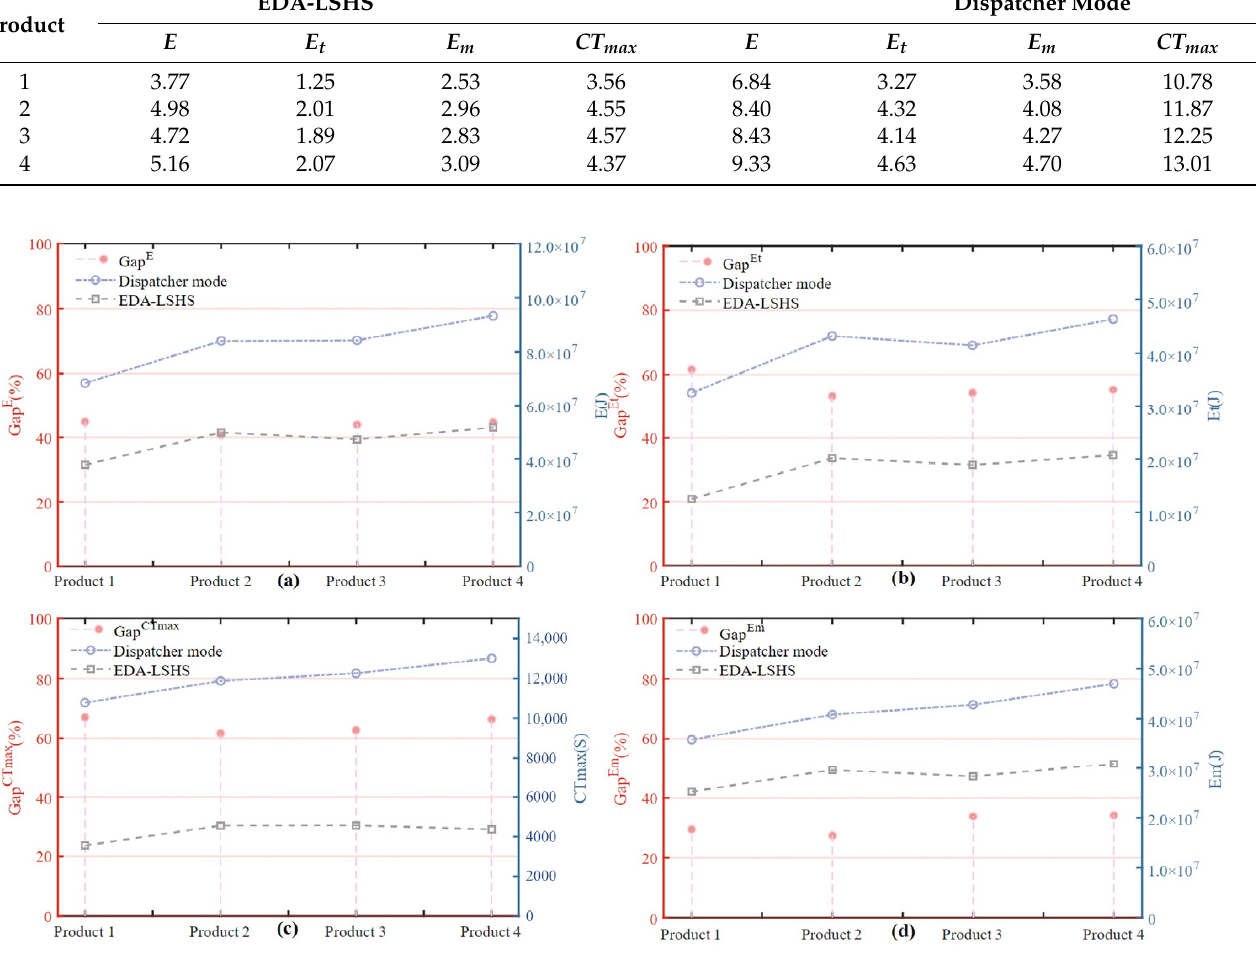
Figure 12. The four gaps in the four product instances: ( a ) Gap E ; ( b ) Gap Et ; ( c ) Gap CT max ; ( d ) Gap Em . Table 4. The max gap, average gap, and min gap of four Table 3. Results for the EDA-LSHS algorithm and the dispatcher mode.